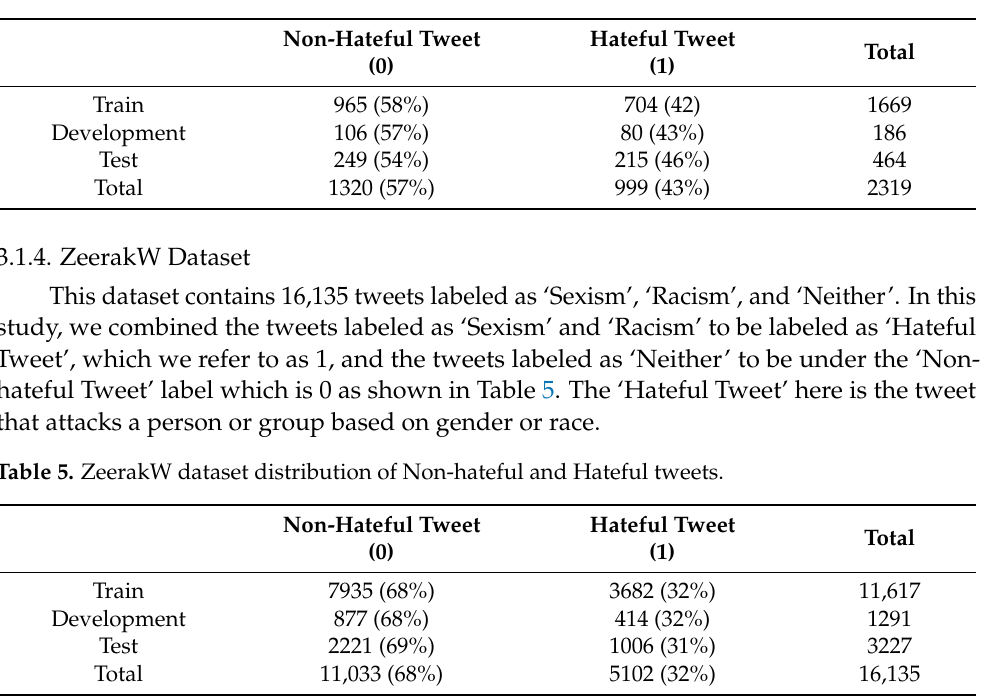
Table 4. COVID-HATE dataset distribution of Non-hateful and Hateful tweets.